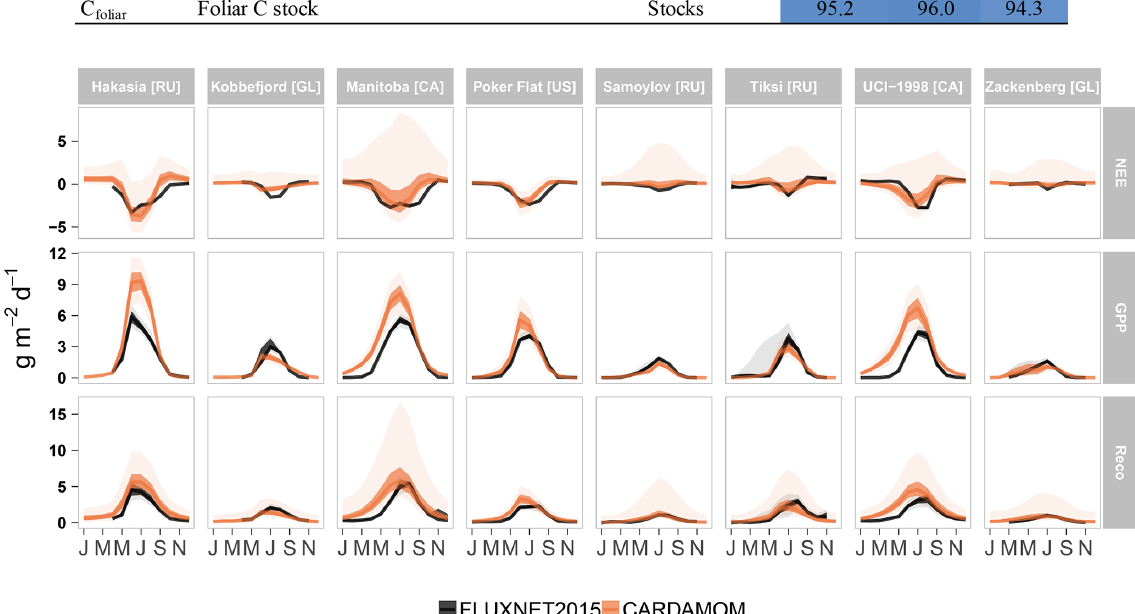
Figure 4. Monthly aggregated seasonal variability of observed (FLUXNET2015) and modelled (CARDAMOM) C fluxes (NEE, net ecosys- tem exchange; GPP, gross primary production; R eco , ecosystem respiration) across eight low- and high-Arctic sites (Hakasia, Kobbefjord, Manitoba, Poker Flat, Samoylov, Tiksi, UCI-1998, and Zackenberg). Each of these sites, located in different countries (RU – Russia; GL – Greenland; CA – Canada; US – United States) feature different meteorological conditions and vegetation types (Table S4). Uncertainties represent the 25th and 50th percentiles (darker shade) and the 5th and 95th percentiles (lighter shade) of both field observations and the CARDAMOM